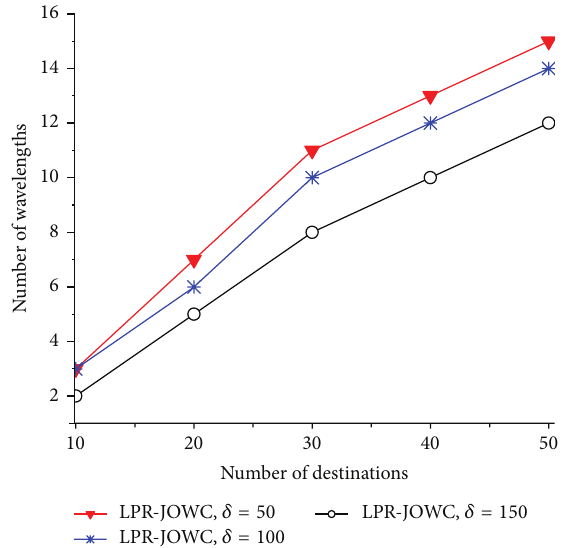
Figure 5: Required number of wavelength channels versus number of